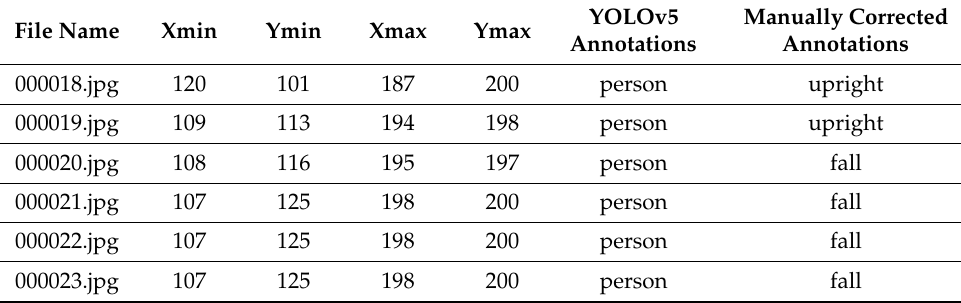
Table 1. Example bounding box coordinates and